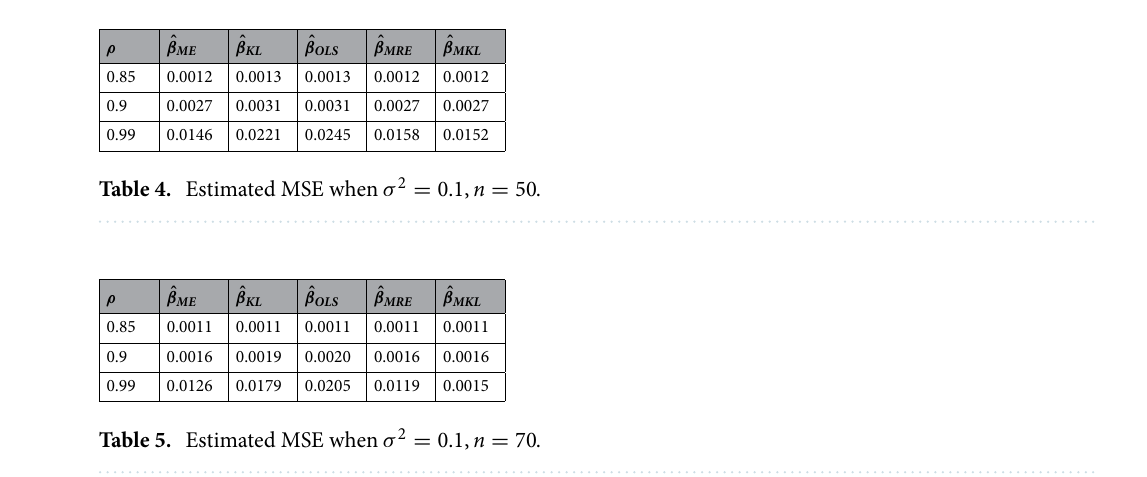
Table 5. Estimated MSE when σ